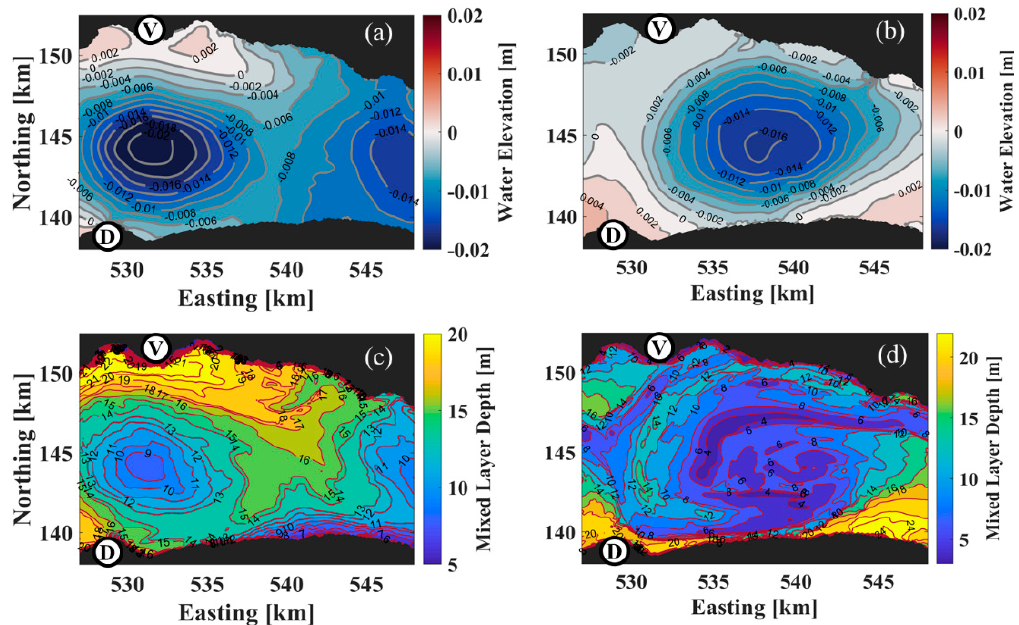
Figure 12. Simulated surface water elevation for ( a ) 20 September 2019 at 18:00 UTC and ( b ) 21 September 2019 at 18:00 UTC. Simulated MLD for ( c ) 20 September 2019 at 18:00 UTC and ( d ) 21 September 2019 at 18:00 UTC. Colorbars show ranges. V and D: reference points marked in Figure 1.